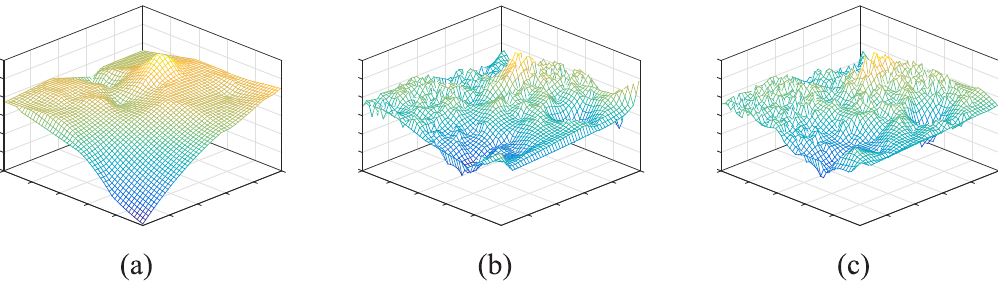
Figure 9. Recovered signals (generated sensing images). ( a ) Interpolation method; ( b ) Enhanced crowdsensing approach with 3 time slots combination; ( c ) Enhanced crowdsensing approach with 6 time slots